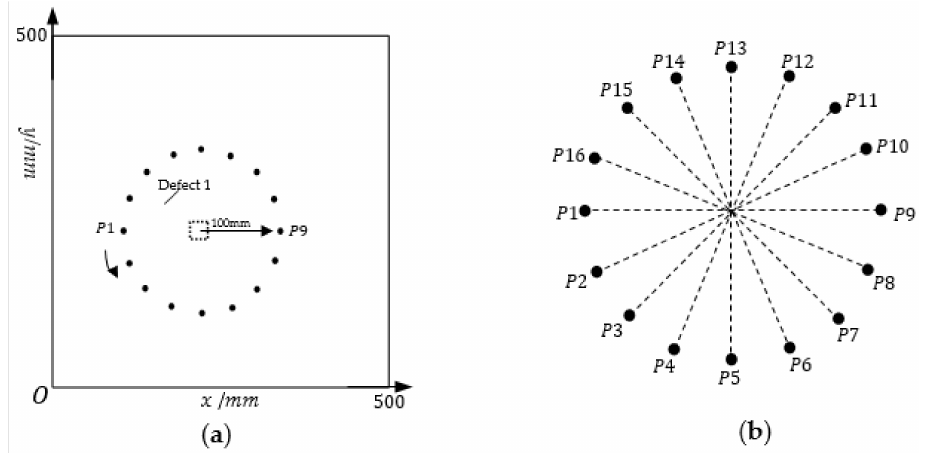
Figure 4. Schematic diagram of the experimental setup: ( a ) sensor arrangement and defect setting; ( b ) sensing path.